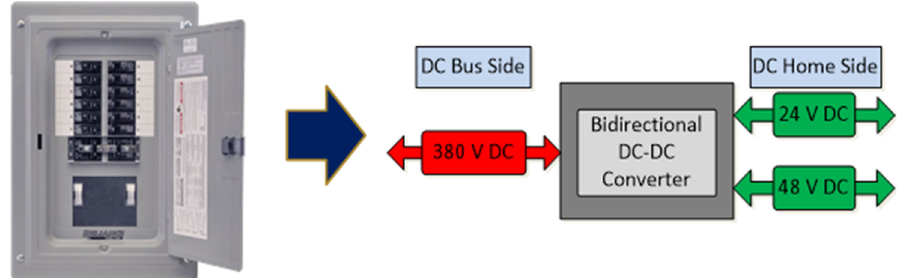
Figure 5. Traditional AC breaker panel ( left ) and Single Input, Multiple Output Bidirectional DC/DC converter equivalent ( right